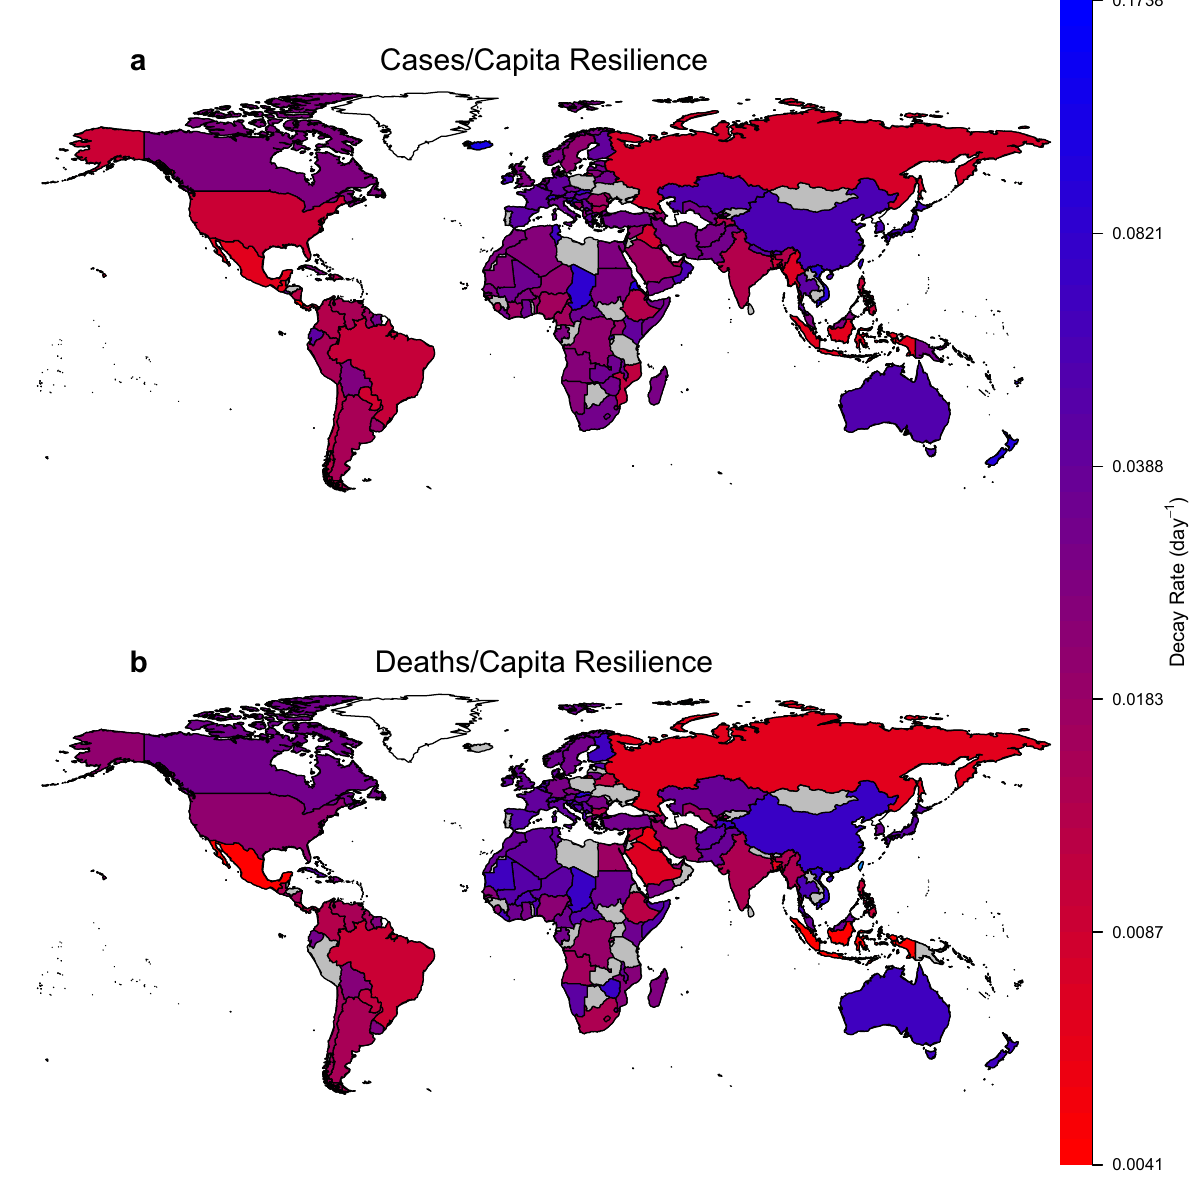
Figure 3. World maps of country-level resilience to COVID-19. Decay rate (d −1 ) from the first peak of: ( a ) cases/capita. ( b ) deaths/capita. In both cases countries are coloured where the fit of an exponential decay has r 2 ≥ 0.8. Countries in grey either have insufficient data or a poorer fit of exponential decay. Country/region boundaries plotted in R using the ‘maps’ package (ver. 3.3.0; https:// CRAN.R- proje ct. org/ packa ge=